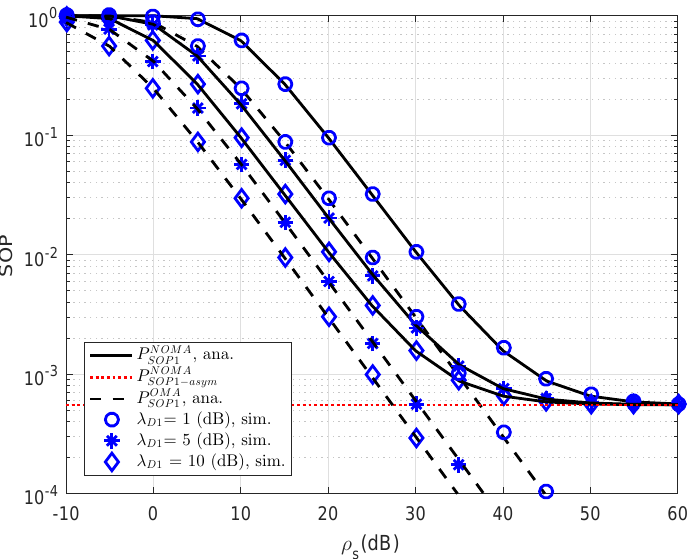
Figure 4. Comparison study on SOP of NOMA and OMA for User D1 versus transmit ρ S = ρ R as varying λ D 1 .